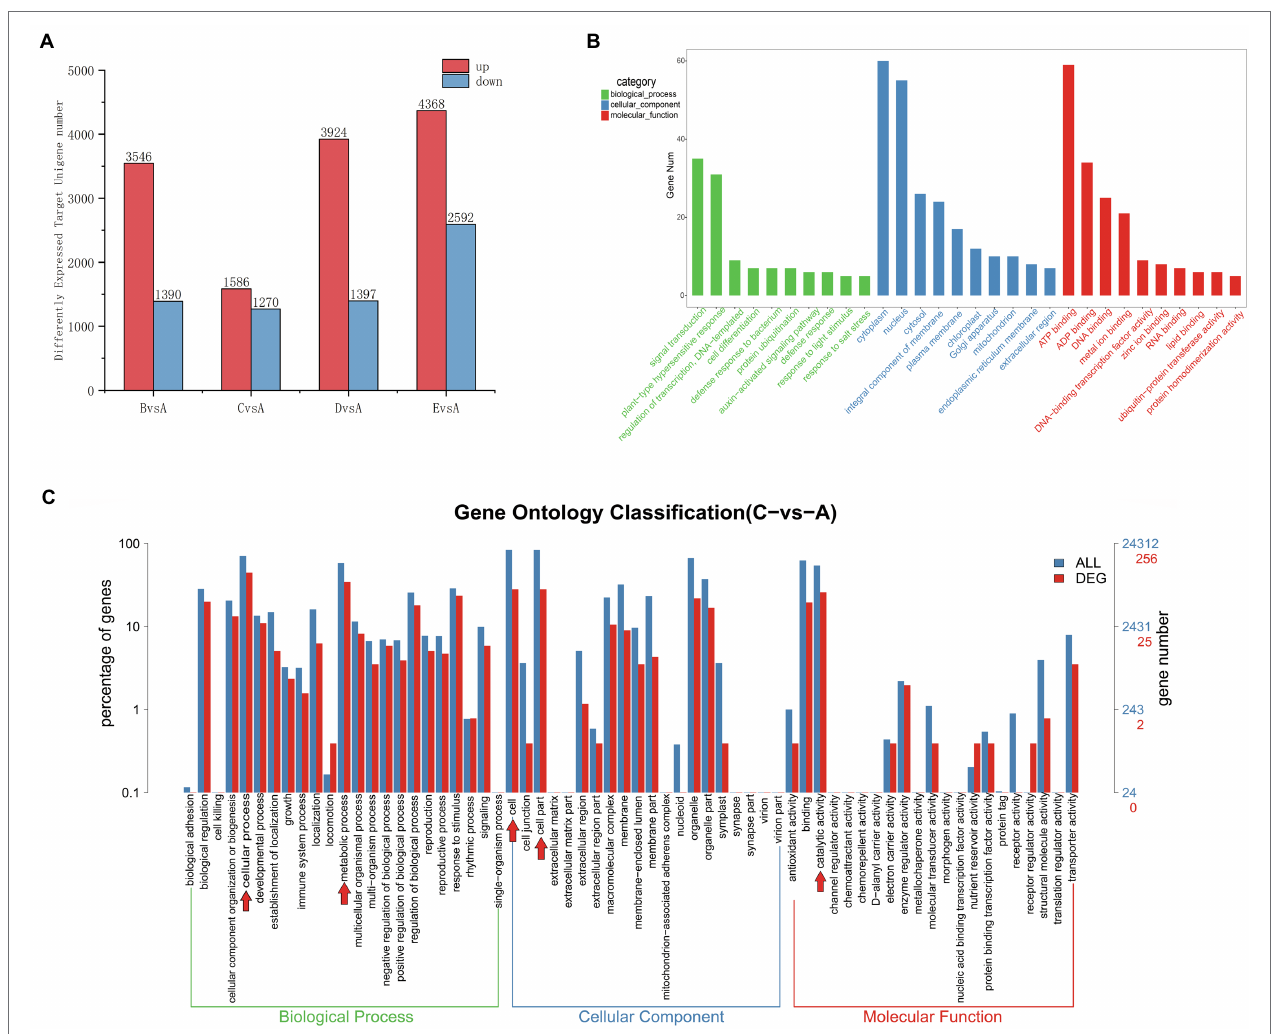
FIGURE 6 | (A) Distribution of the number of differentially expressed target unigenes. The x-axis indicates which stage is being compared to the A stage, and the y-axis indicates the number of differentially expressed target genes. (B) Top 30 GO enrichment categories of the target unigenes (stage CvsA). The x-axis is the name of the GO entry, and the y-axis is the number of genes enriched in the GO entry. (C) Differently expressed miRNA target genes (red) shown in a GO Level2 horizontal distribution comparison plot (stage CvsA). For comparison, all target genes are plotted in blue. Red arrows indicate the 5 GO term subcategories with the highest number of DEGs for a particular stage comparison. The x-axis presents the different GO functional classifications, and the y-axes on the left and right represent the percentage and absolute number of unigenes classified to each GO category, respectively (stage